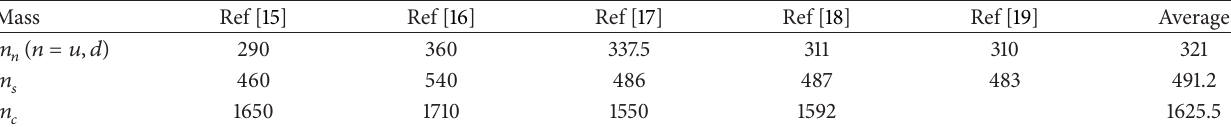
Table 2: Constituent quark masses (in MeV) in different phenological models.